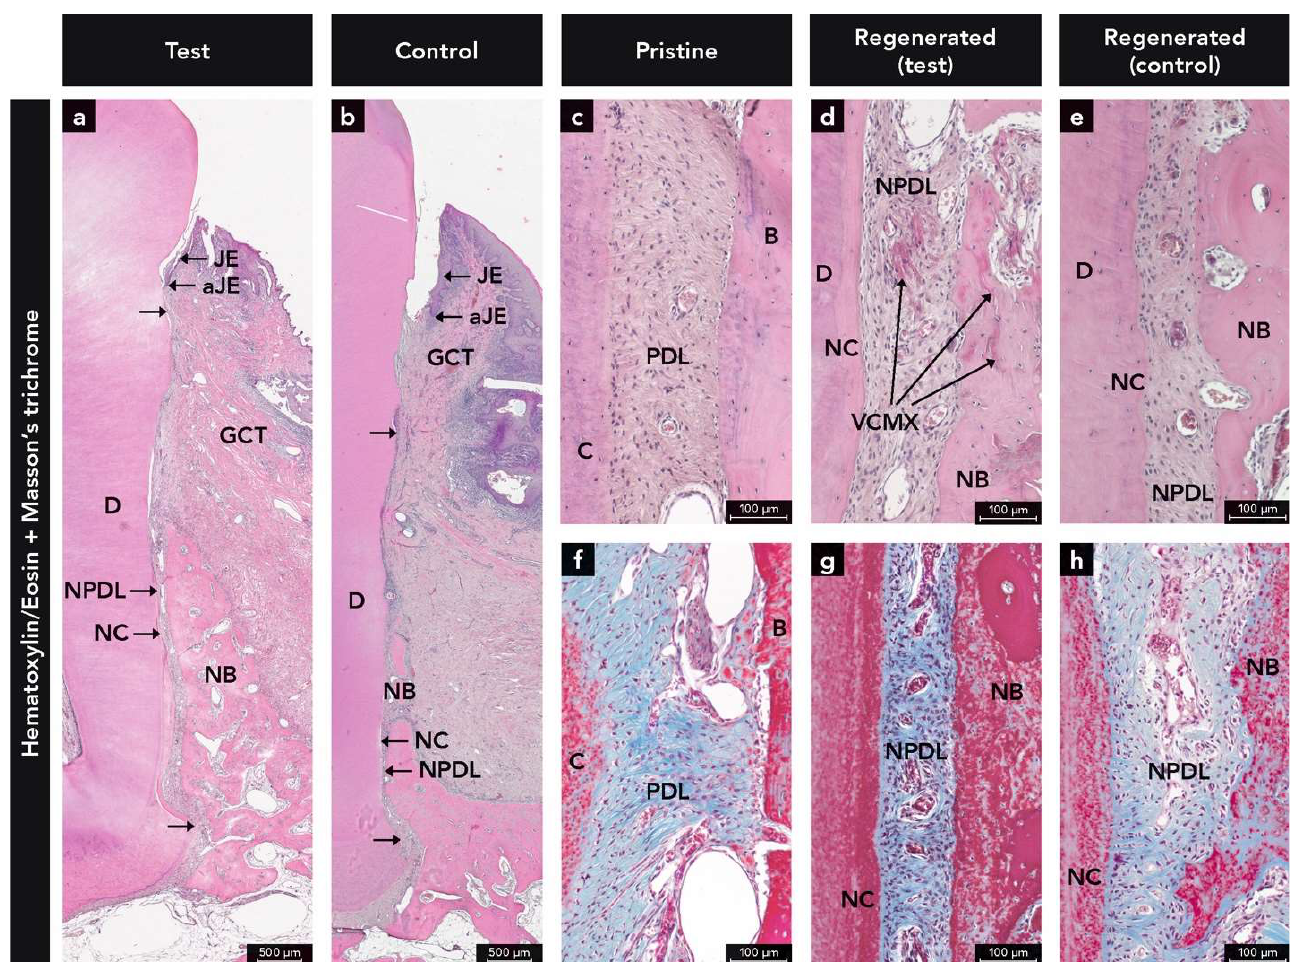
Figure 1. Micrographs illustrating periodontal regeneration (i.e., formation of a new junctional epithelium (JE), new cementum (NC), new periodontal ligament (NPDL), and new bone (NB)) at ( a , d , g ) test and ( b , e , h ) control sites; ( c , f ) Paraffin sections demonstrating the periodontal ligament (PDL), cementum (C), and bone (B) at non-treated/pristine sites; ( d ) Micrograph illustrating the integration of the volume stable collagen matrix (VCMX) into NPDL and NB; Paraffin sections staining: ( a – e ) hematoxylin & eosin and ( f – h ) Masson’s trichrome; aJE, apical end of the JE; D, dentin; GCT, gingival connective tissue.